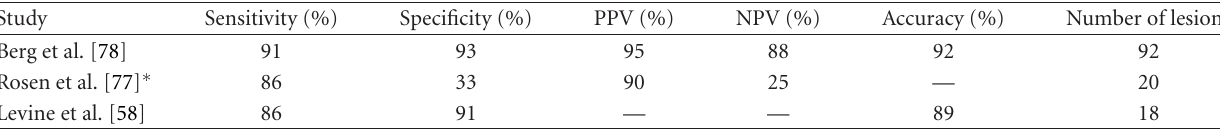
Table 2: Results of PEM studies. NPV: negative predictive value; PEM: positron emission mammography; PPV: positive predictive value.